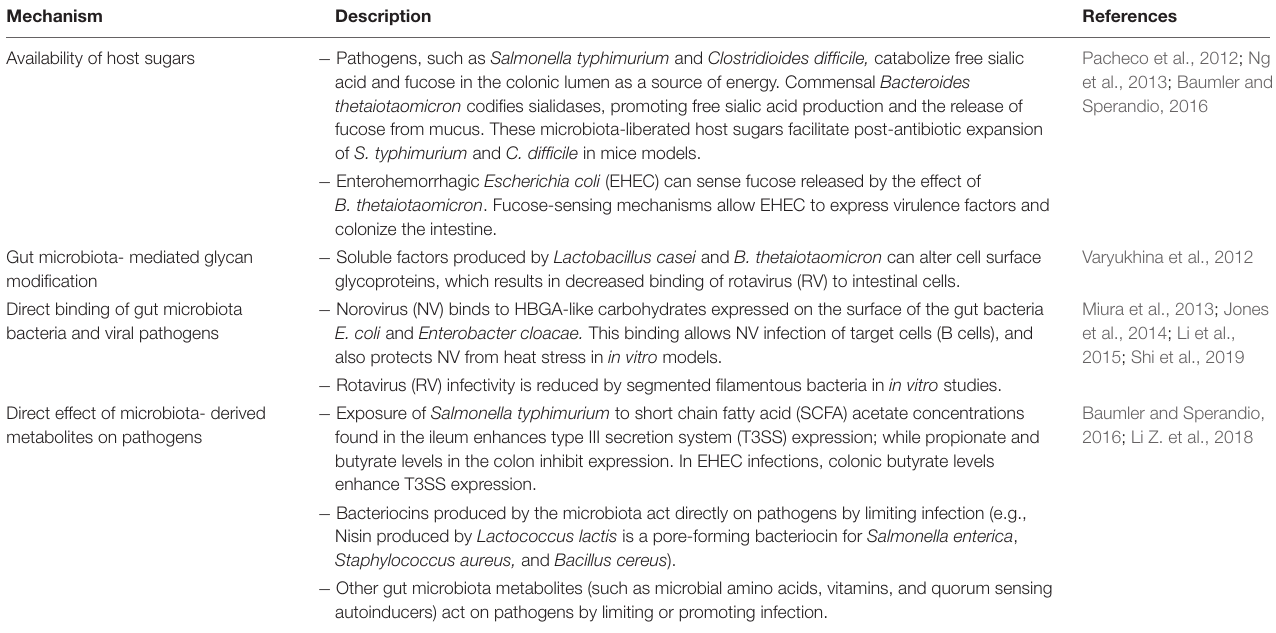
TABLE 2 | Mechanisms involving direct interaction between the gut microbiota and